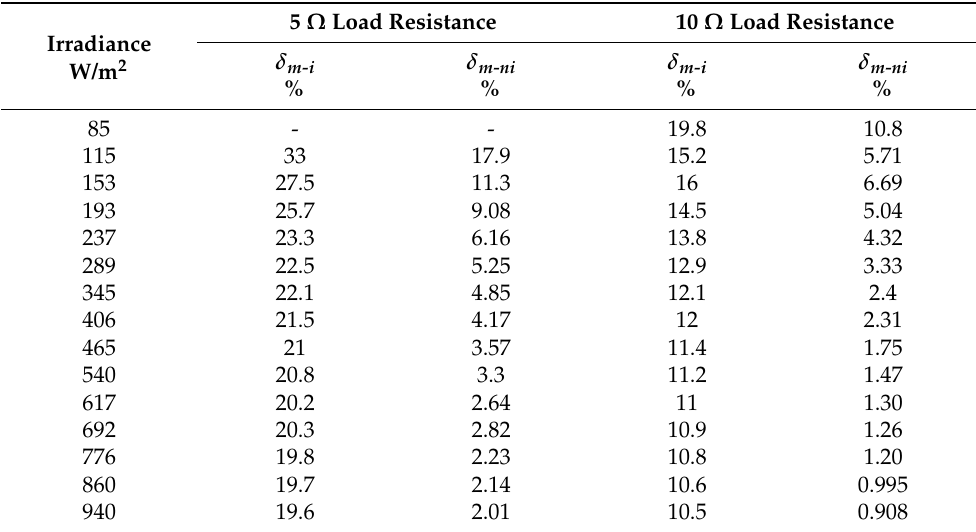
Table A3. Differences between measured and calculated values for a 10 W PV panel.